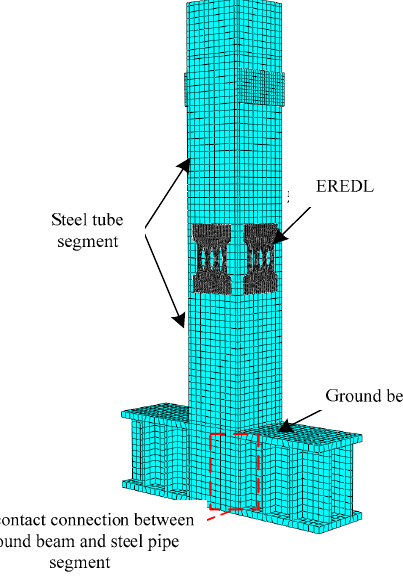
Figure 6. Finite element model of PSCFET.